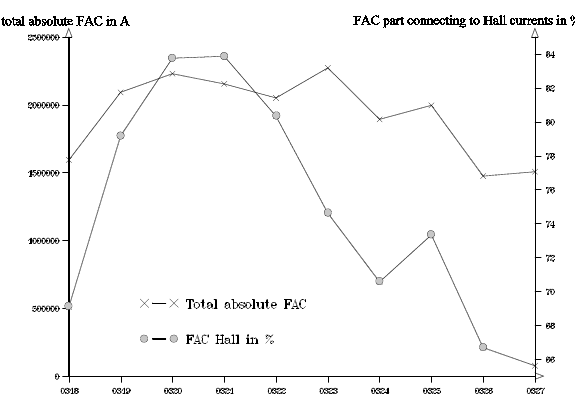
Fig. 9. Total absolute FAC in A (crosses, scale on the left side of graph) and percent of FAC connecting to ionospheric Hall currents in % (dots, scale on the right side of the graph) as a function of time over the analysis interval.